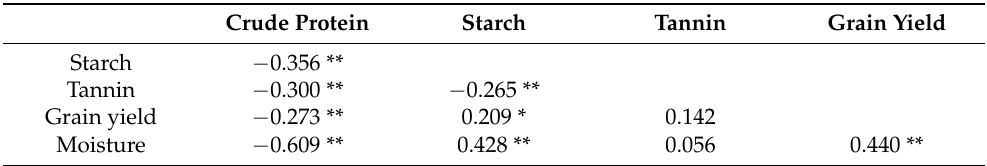
Table 3. Pearson’s correlation among crude protein, total starch and tannin contents in 100 sorghum accessions.